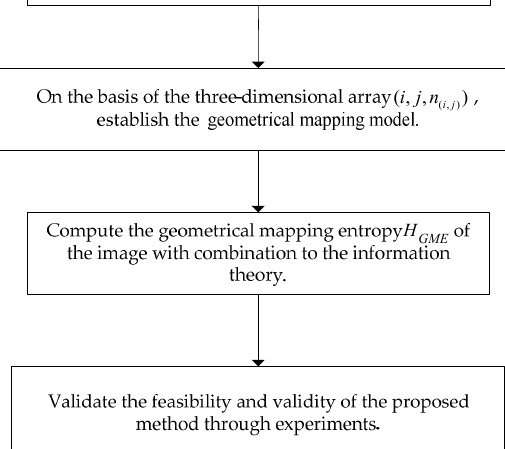
Figure 1. The general framework of the GME